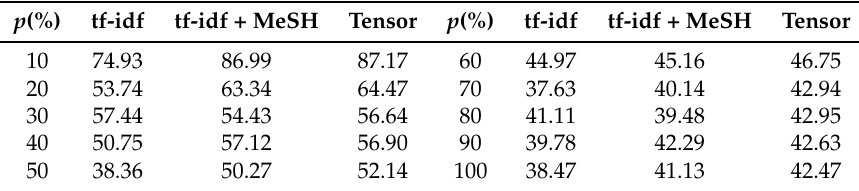
Table 7. Cosine similarity, k-means clustering and F-measure.